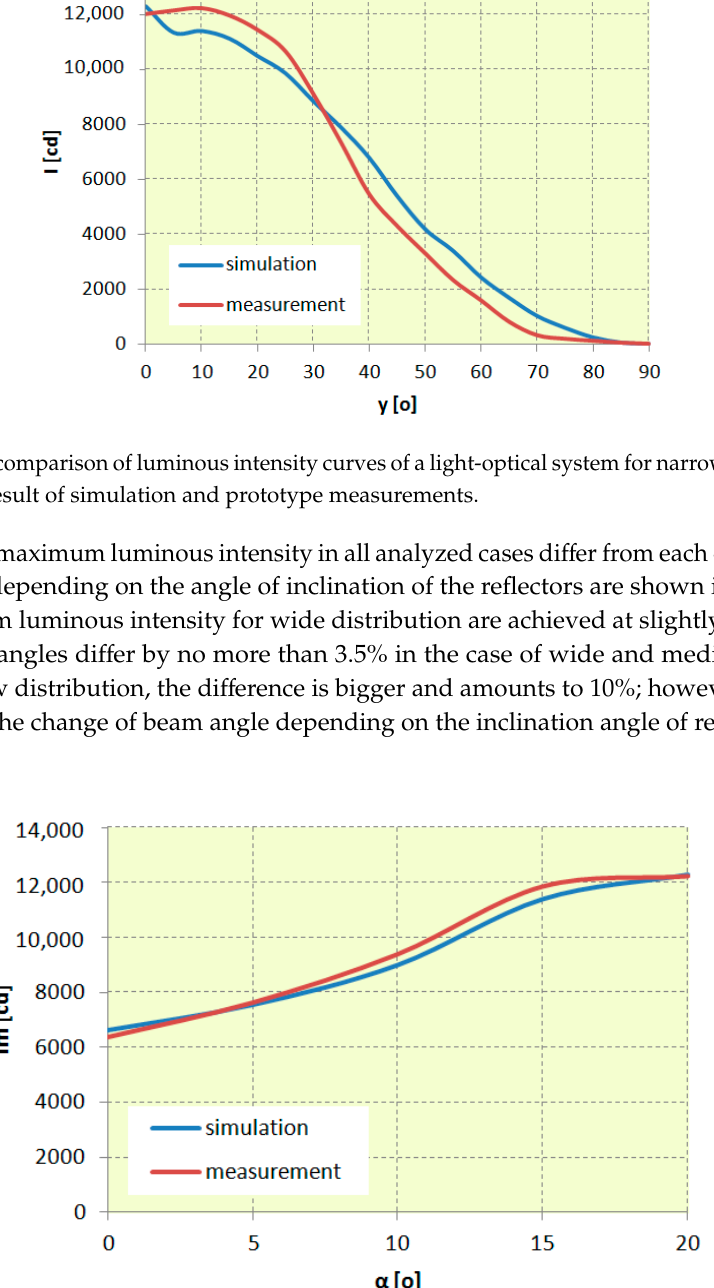
Figure 21. The comparison of luminous intensity curves of a light-optical system for medium wide distribution obtained as a result of simulation and prototype measurements.